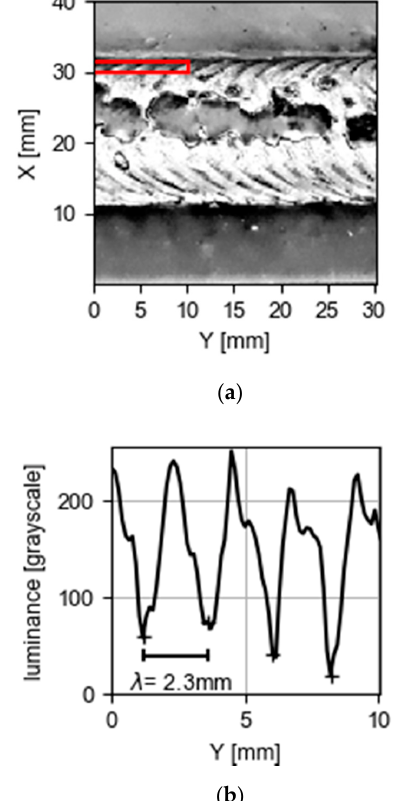
Figure 10. ( a ) Wavy-shaped track generated in the first deposited bead due to the wavelength of the oscillatory path. Note that five marks are in a red box; ( b ) Luminance values of the part of the photo bordered by the red box.